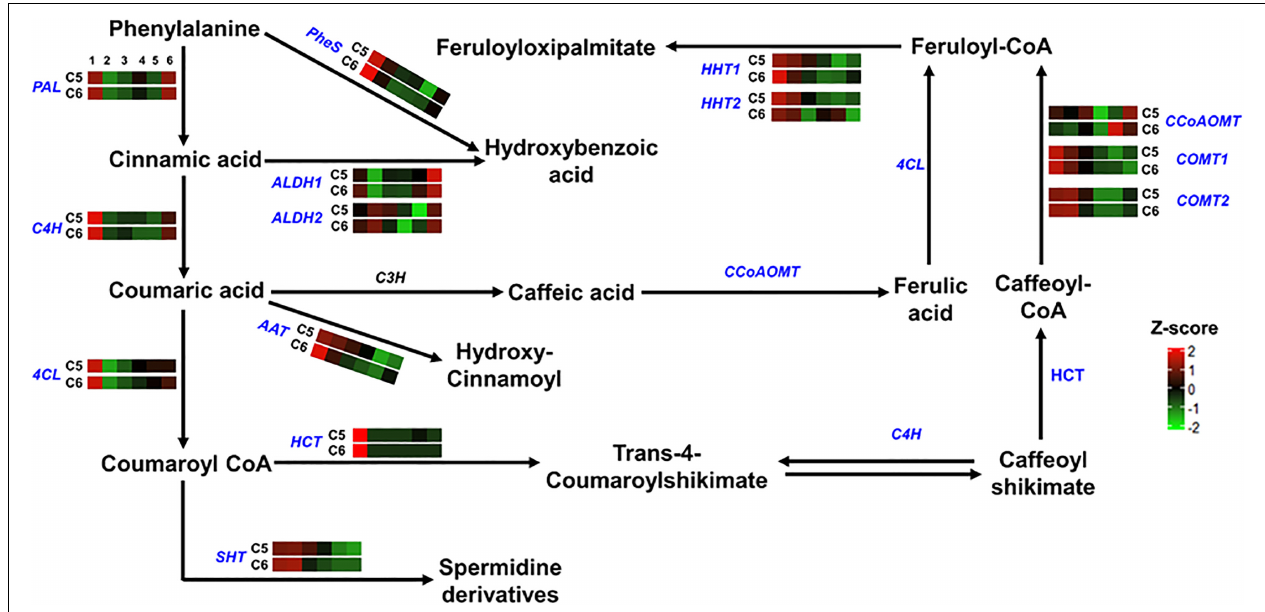
FIGURE 5 | Hydroxycinnamic acids pathway. The colored boxes show the accumulation pattern of genes involved in hydroxycinnamic acids pathway that were assessed by qPCR at different berry developmental stages, including fruit-set (1), prevéraison (2), véraison (3), postvéraison (4), ripe-skin/flesh (5), and ripe-seeds (6). Red boxes indicate higher levels of expression, and green boxes indicate lower expression levels. The color brightness is directly proportional to the expression ratio, according to the color scale. PAL , phenylalanine ammonia-lyase; C4H , trans-4-coumarate biosynthesis; 4CL , 4-coumaroyl:CoA-ligase; PheS , phenylalanine ligase; ALDH , aldehyde dehydrogenase; AAT , anthocyanidin 3- O -glucoside 6 (cid:48)(cid:48) - O -acyltransferase; HCT , shikimate O -hydroxycinnamoyl transferase; SHT , spermidine hydroxycinnamoyl transferase; HHT , omega-hydroxypalmitate O -feruloyl transferase; CCoAOMT , caffeoyl-CoA O -methyltransferase; COMT , caffeic acid 3- O